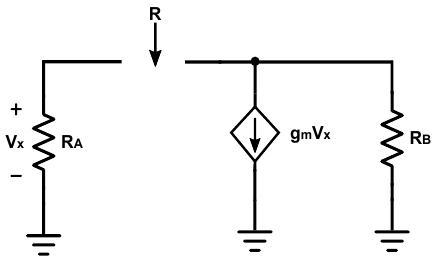
Figure 1. Similar configurations of some capacitors in OCTC